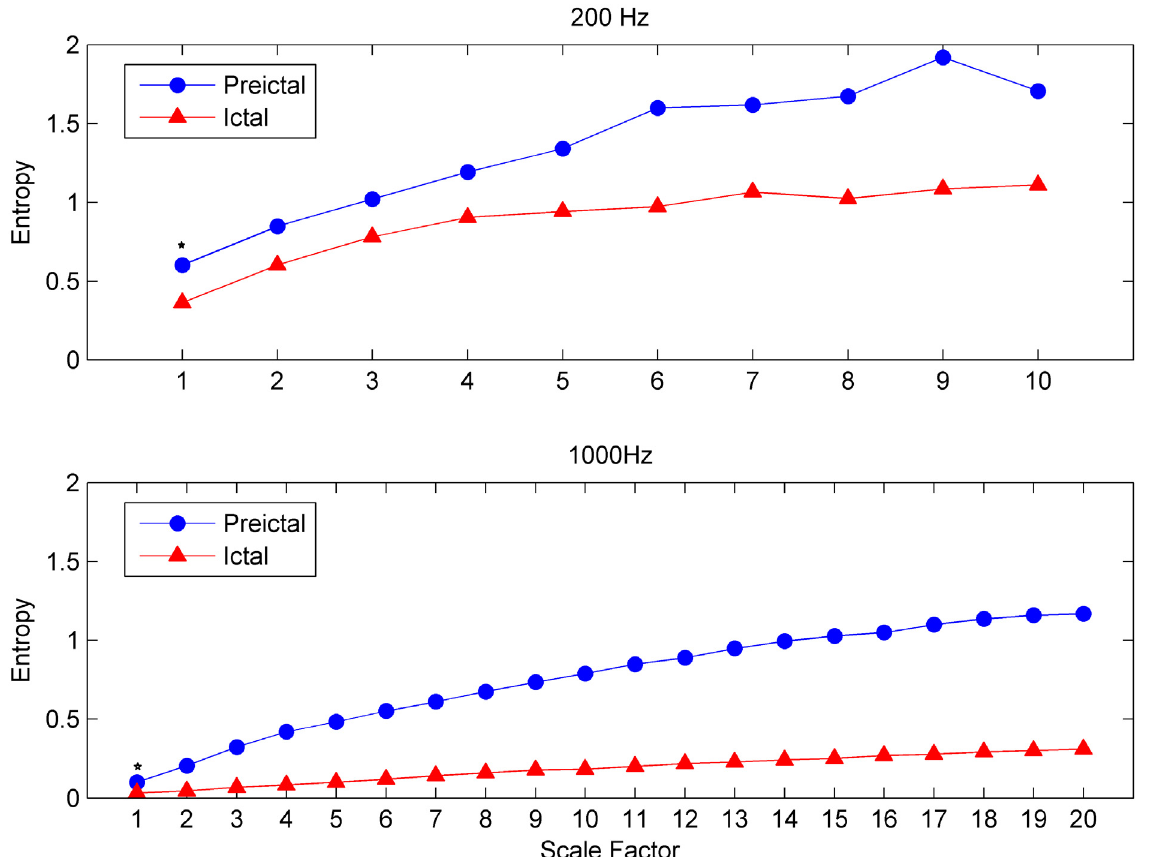
Fig 2. The multiscale entropy from a single seizure in a single patient. Multiscale entropy of preictal (blue line) and ictal (red line) states from a single seizure in a single patient, respectively, showing that multiscale entropy with higher sampling frequency (1000Hz, lower panel) can reveal greater difference between ictal and pre-ictal states than lower sampling frequency (200Hz, upper panel). The curve also seems smoother and can be calculated to a larger scale factor. Due to more data points in high sampling frequency, the points on high sampling frequency (lower panel) at scale 20 are corresponding to points on low sampling frequency (upper panel) at scale 4. Each panel represented MSE from one seizure in one patient. The sample entropy was the entropy at scale 1 (marking “ * ” in the figure).